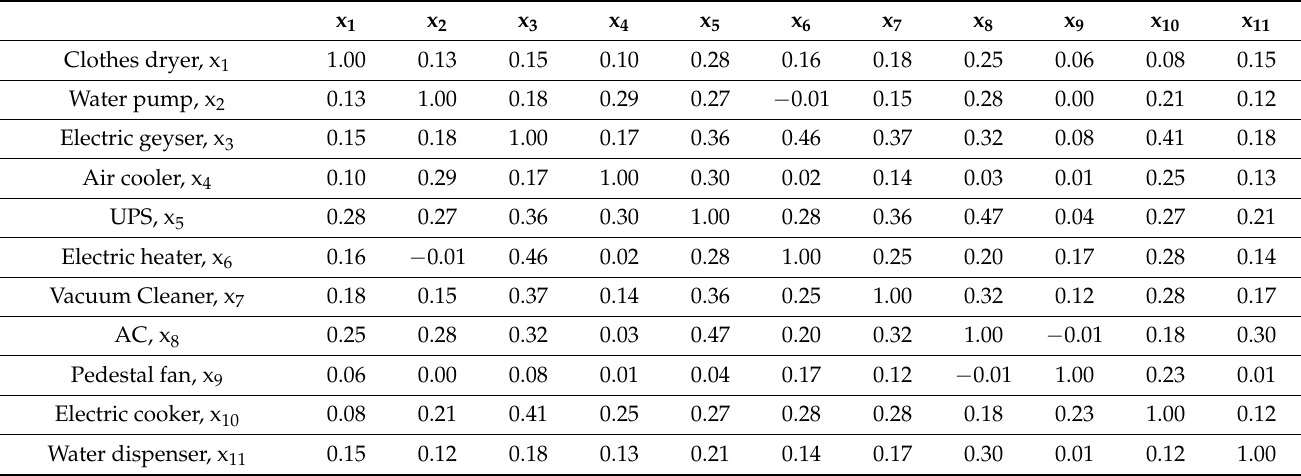
Table 4. Correlation of household electrical appliances.